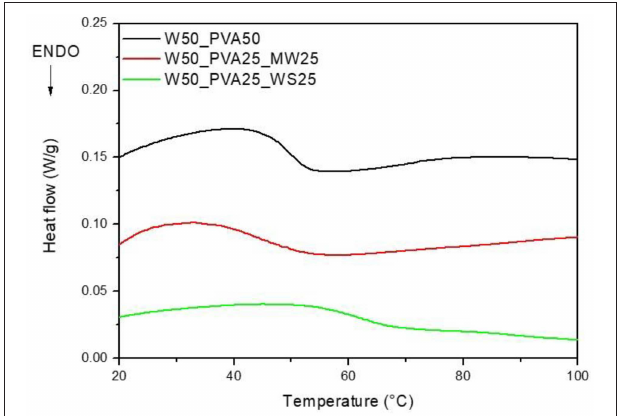
FIGURE 3 | DSC analyses on neat PVA and PVA_WS.